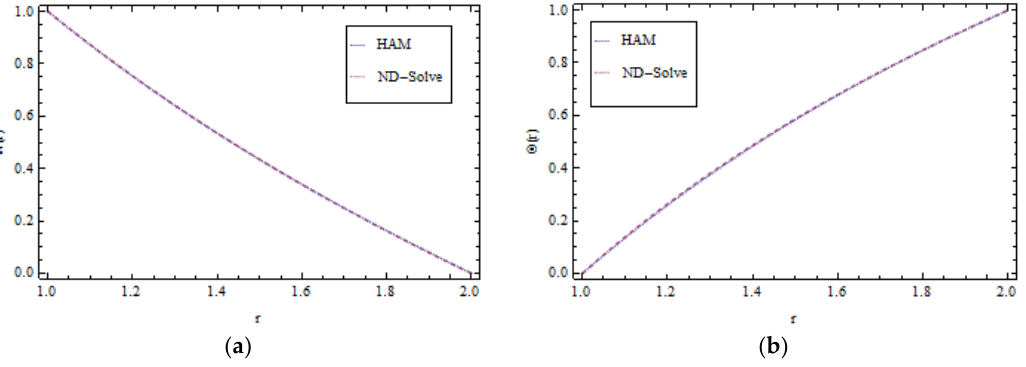
Figure 4. Velocity and temperature comparison of homotopy analysis method (HAM) and ND-sole methods: ( a ) velocity; and ( b ) temperature. Table 1. The homotopy-pade approximation of u ( r ) and θ ( r ) for β = 0.2, δ = 2, K = 0.1, M = 0.2.